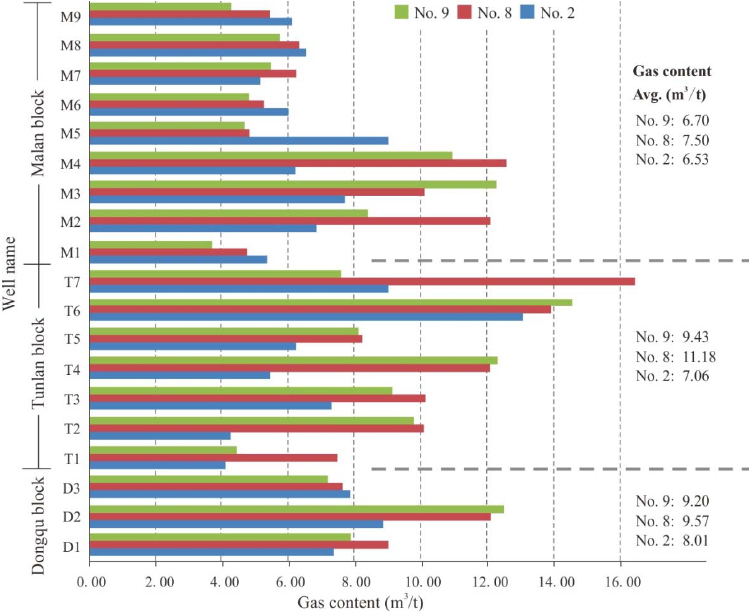
Figure 3. Variable gas content from the CBM wells of the explored Nos. 2, 8, and 9 coals.